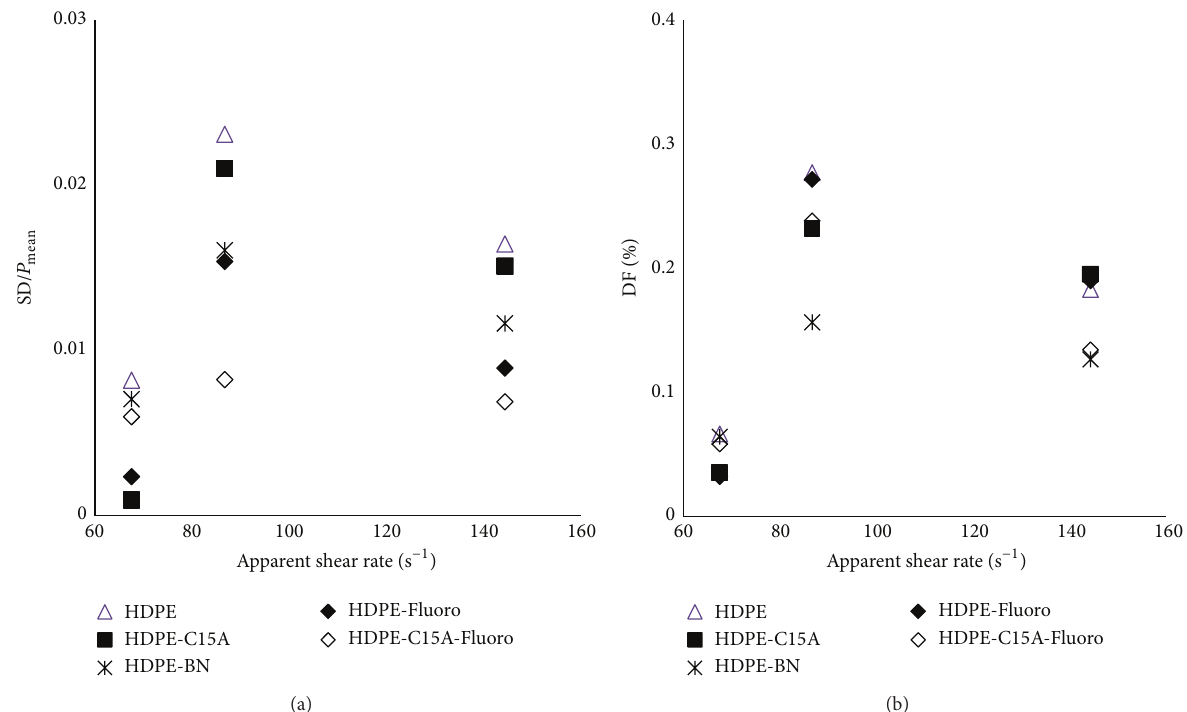
Figure 12: (a) Ratio of standard deviation and the mean pressure. (b) Distortion factor as a function of apparent shear rate for HDPE, HDPE- C15A, HDPE-BN, HDPE-Fluoro, and HDPE-C15A-Fluoro at transducer 2